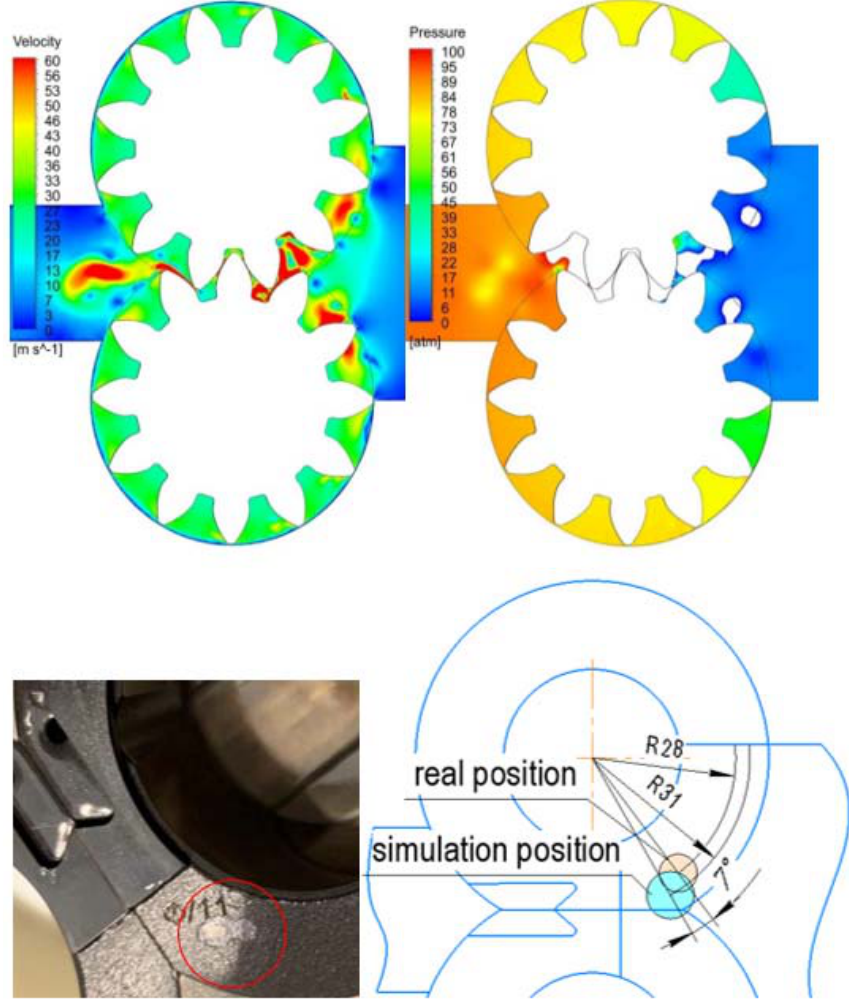
Figure 14. Comparison of the damage to the thrust bearing and simulation results.